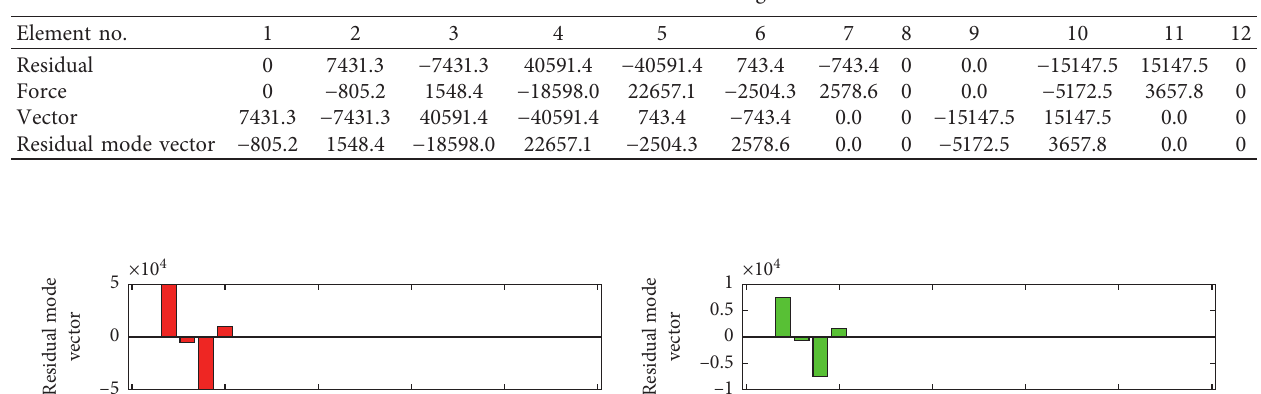
Table 1: Residual mode vector according to elements.